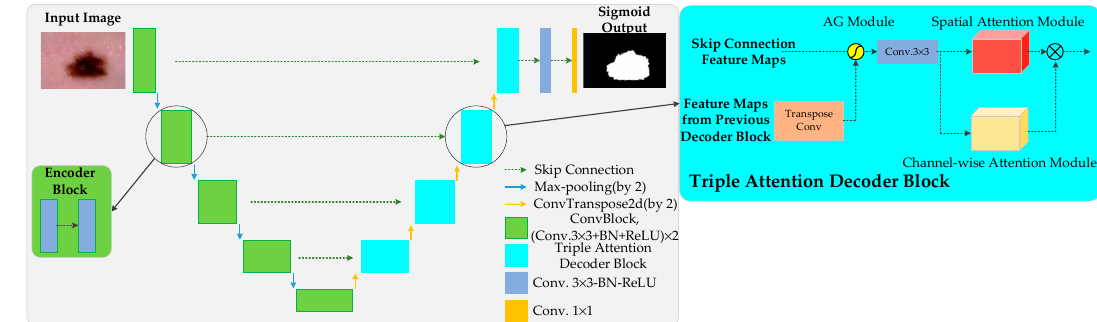
Figure 4. Diagram of the proposed ASCU-Net. AG, attention gate.